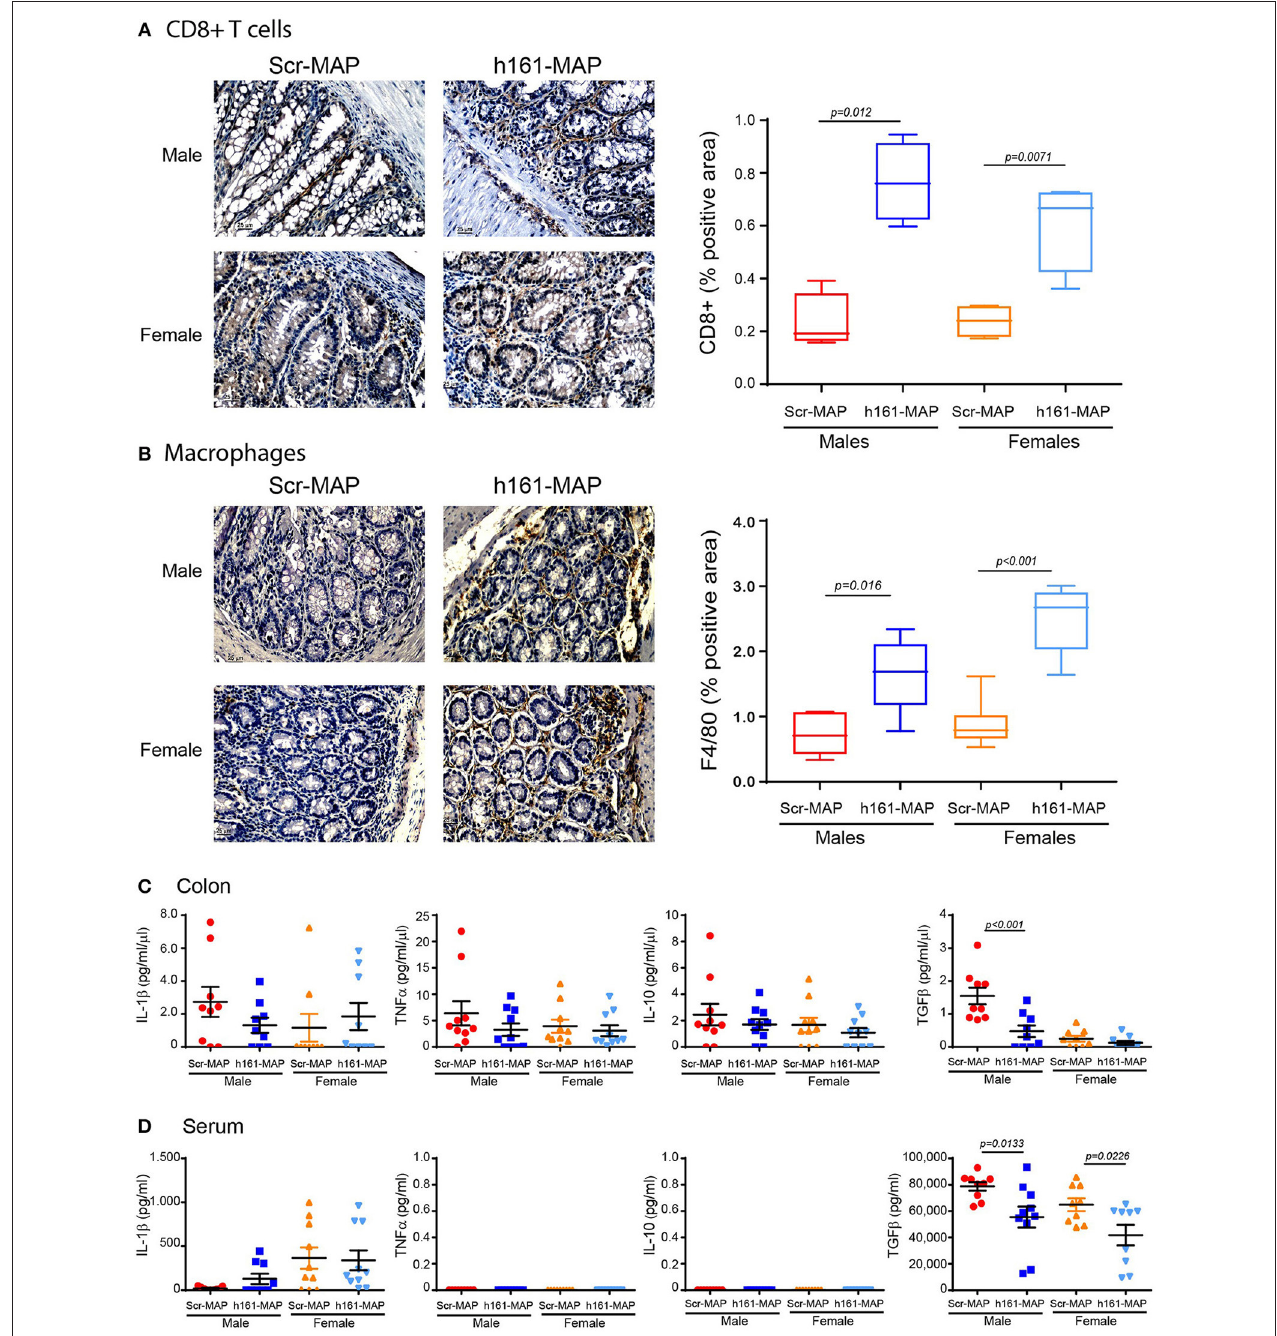
FIGURE 5 | 161-MAP active vaccination increases infiltration of CD8 + T cells and macrophages, and reduces TGF β concentrations. Colon tissue sections were stained for (A) CD8 + or (B) for F4/80, and analyzed for their distribution ( n = 4–5 in each group). Scale bar is 25 µ m. (C) Proteins were extracted from colon segments and the concentrations of IL-1 β , TNF α , IL-10 and TGF β were determined in the lysates by ELISA and normalized to the total protein ( n = 9–10). (D) Concentrations of the same cytokines were determined in the serum samples ( n = 9–10).